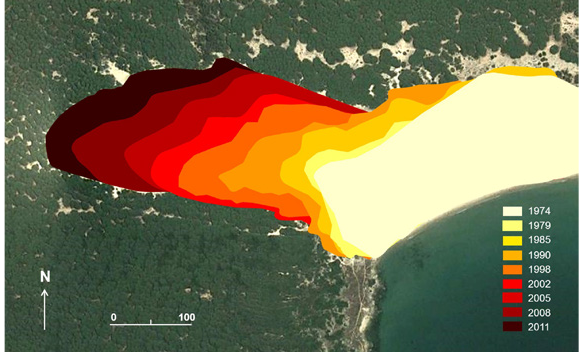
Fig. 6. – Evolution of the Bolonia dunefield from 1974 to 2011.